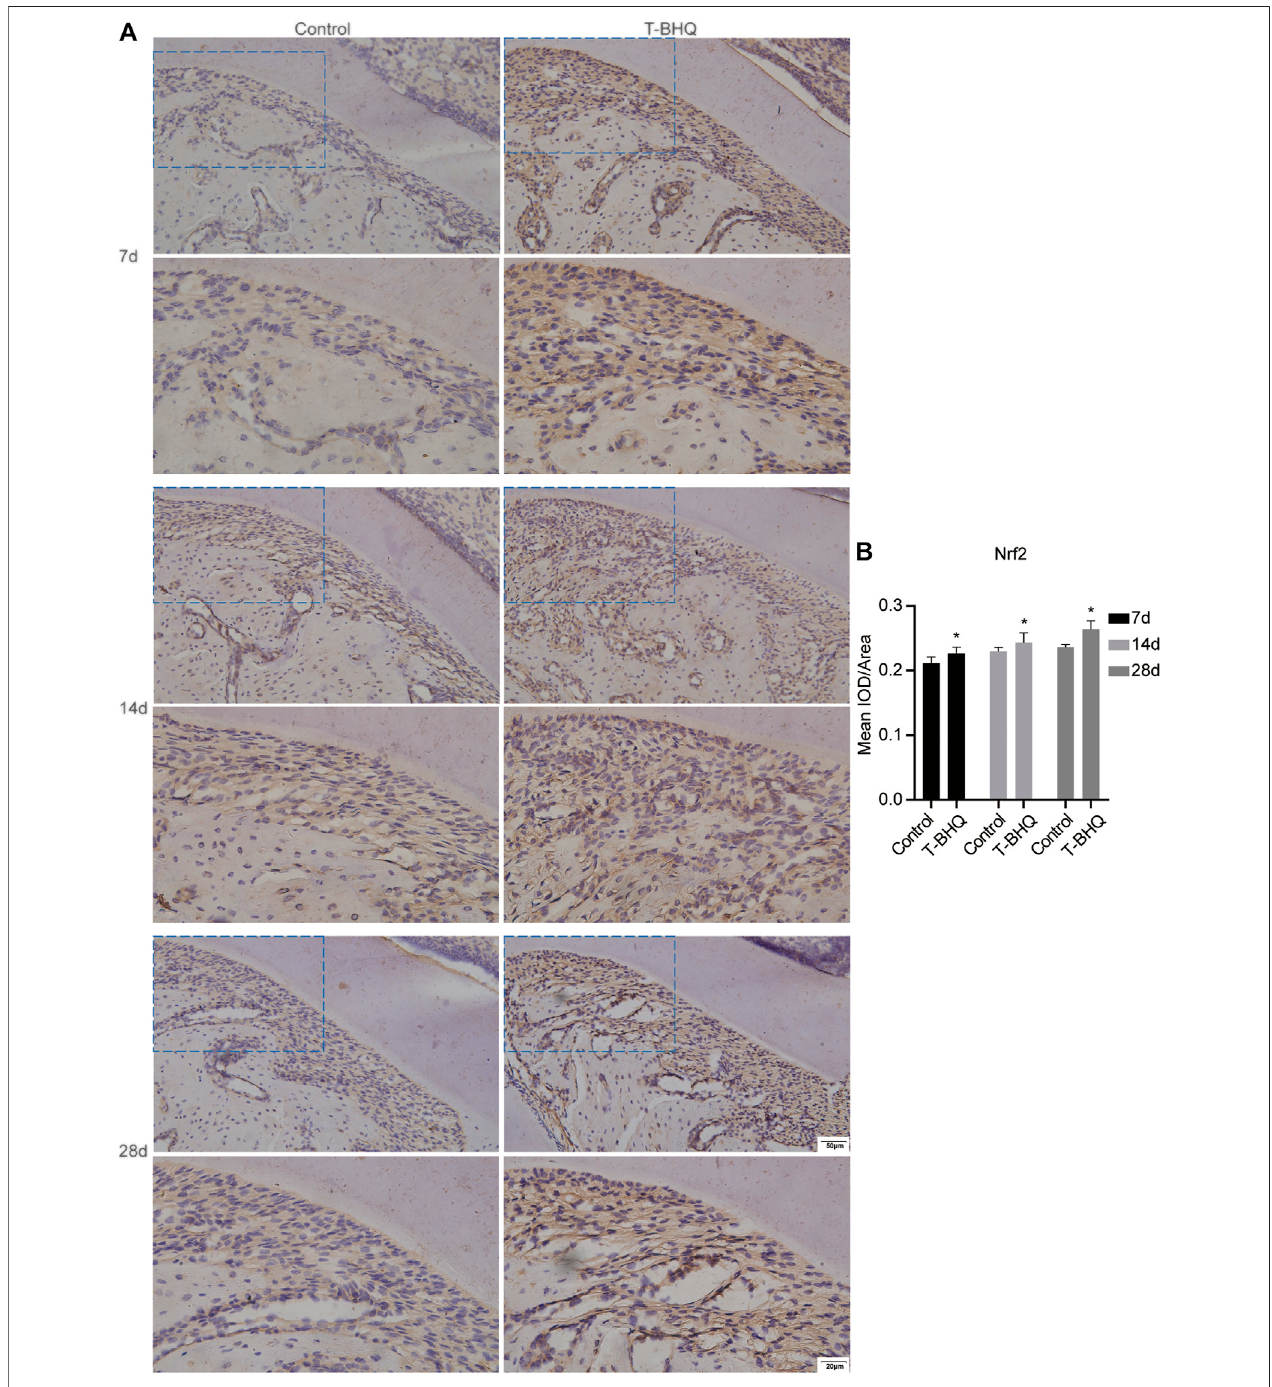
FIGURE5| Theincreasedexpression ofNrf2inthePDLatthetensionsideinorthodonticratswitht-BHQ treatment. (A) T-BHQ, theNrf2activator,couldpromote Nrf2expressioninthePDLatthetensionsideinorthodonticratsthroughIHCstaining.Thescalebars,20and50 µm. (B) Themeanintegratedopticaldensity(IOD)/Area of Nrf2 was quanti fi ed through Image-Pro Plus 6.0 software. N (cid:1) 3 specimens in each group.